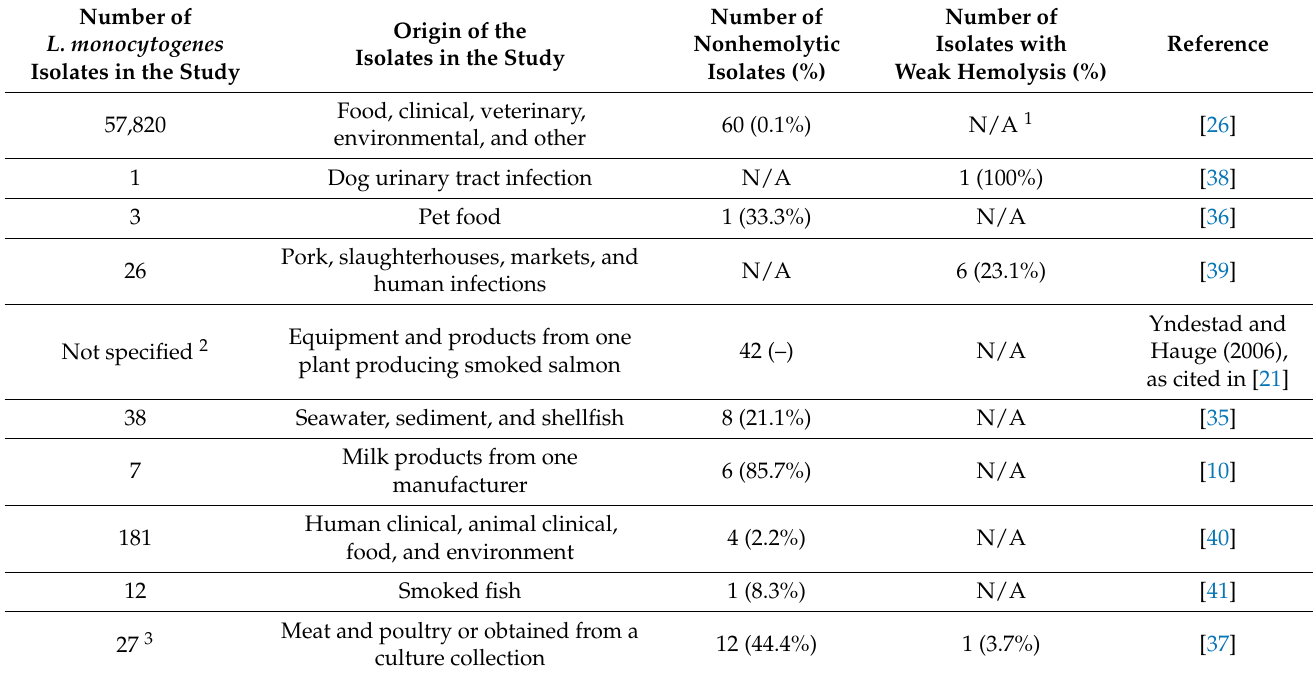
Table 1. Nonhemolytic or weakly hemolytic L. monocytogenes strains reported in the